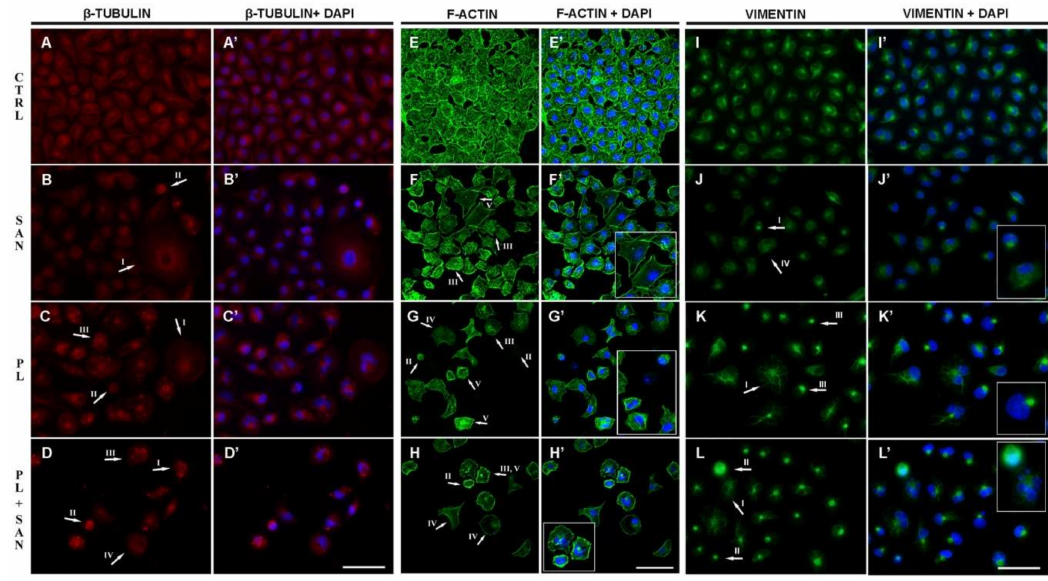
Figure 8. The e ff ects of piperlongumine (PL) and the combination with sanguinarine (SAN) on cytoskeletal proteins in A549 cells: ( A , A (cid:48) – D , D (cid:48) )— β -tubulin, ( E , E (cid:48) – H , H (cid:48) )—F-actin, ( I , I (cid:48) – K , K (cid:48) )—vimentin. Significant changes are marked with arrows—protein organization in the cells with the phenotype of mitotic catastrophe ( I ), apoptotic phenotype ( II ), point accumulation of the protein ( III ), dispersion of the protein’s network ( IV ) and stress fibers ( V ). Bar—50 µ m. 2.7. The influence of PL and Its Combination with SAN Onmigration and the Invasivepotential of A549